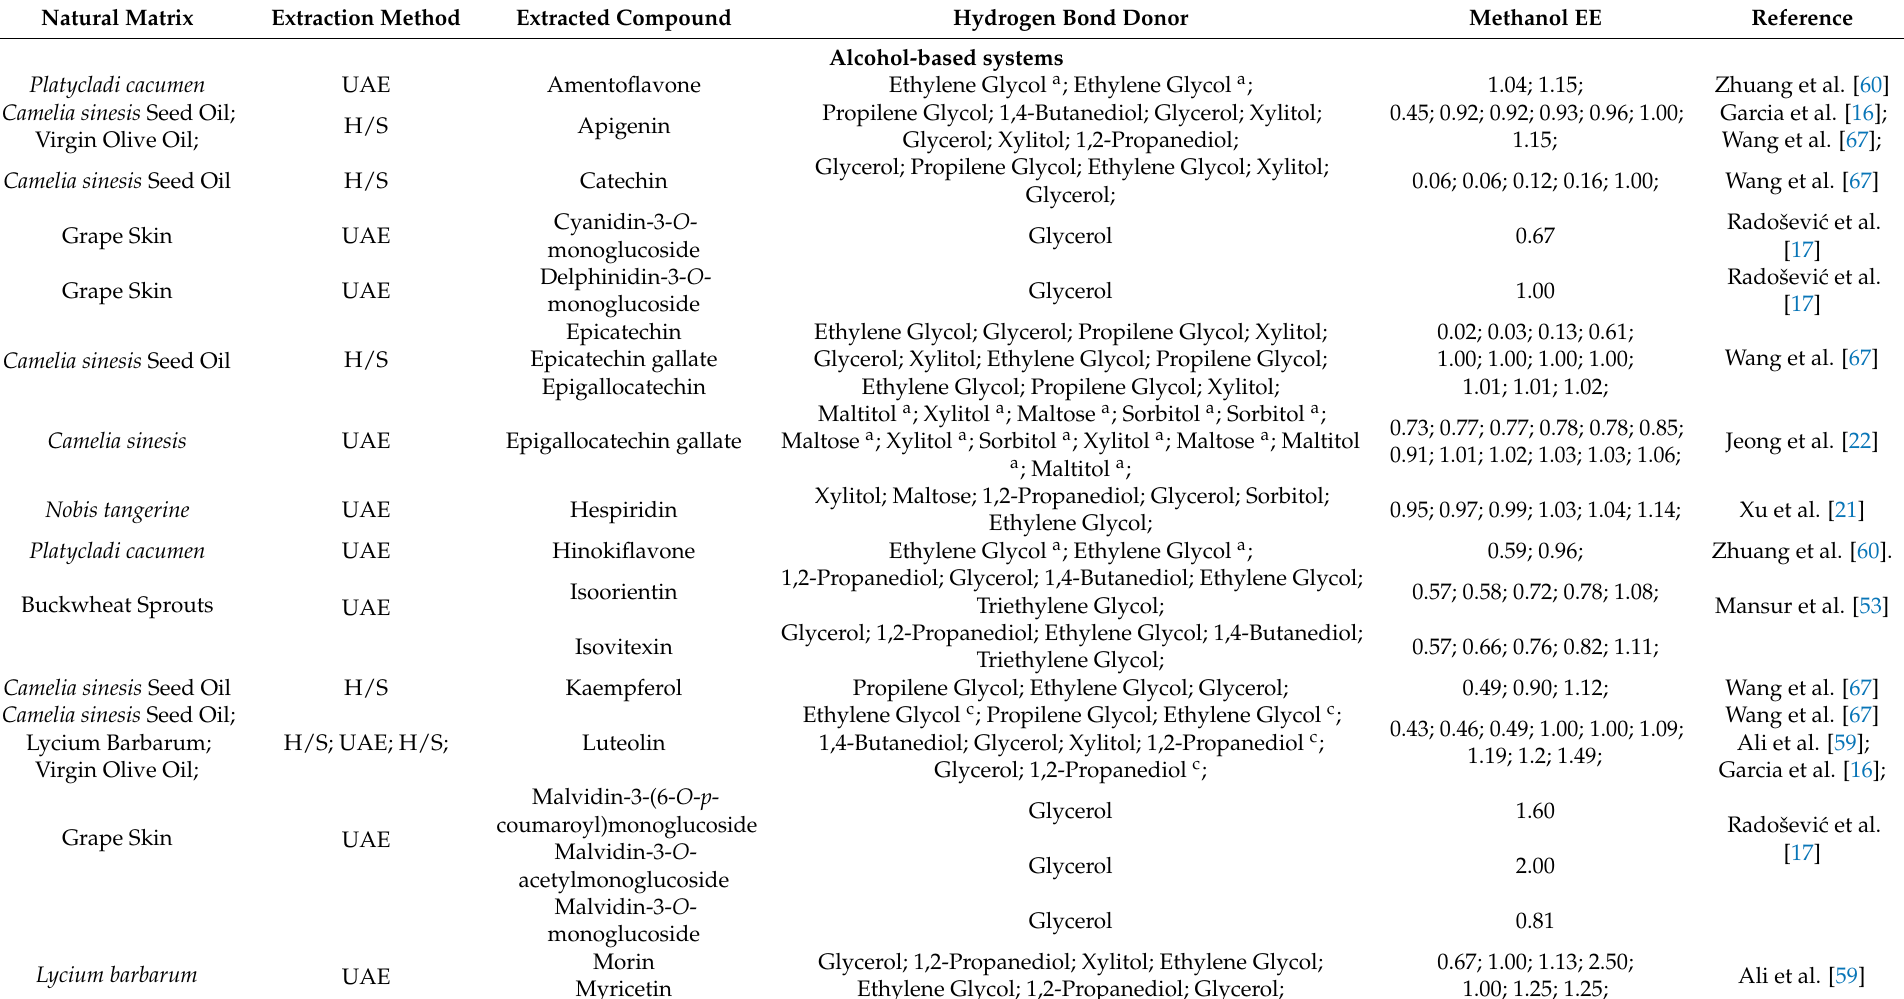
Table 3. Correlation between the natural matrix, extraction method, and DES based on ammonium salts (choline chloride and betaine) and the effect of different HBDs on the extraction efficiency of different flavonoids compared with methanol